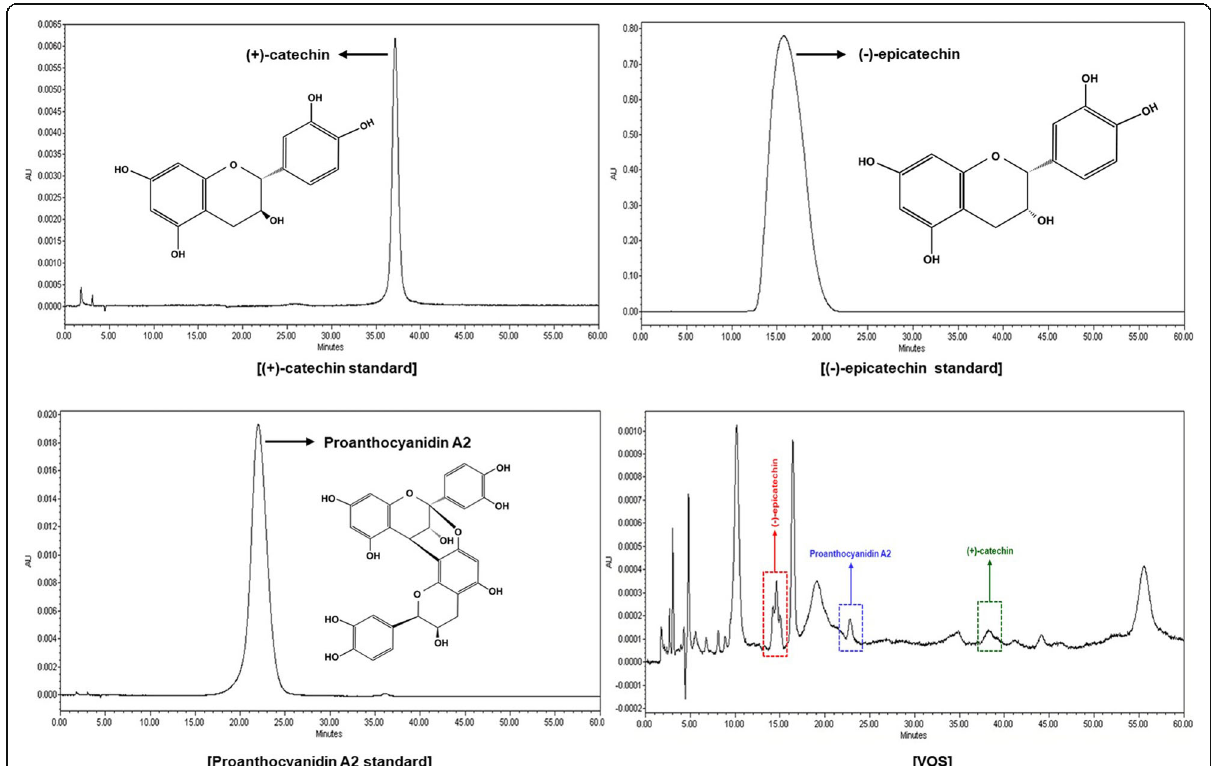
Fig. 2 Chromatography of HPLC analysis of VOS. The major compounds from VOS were analyzed using HPLC as described in Materials and